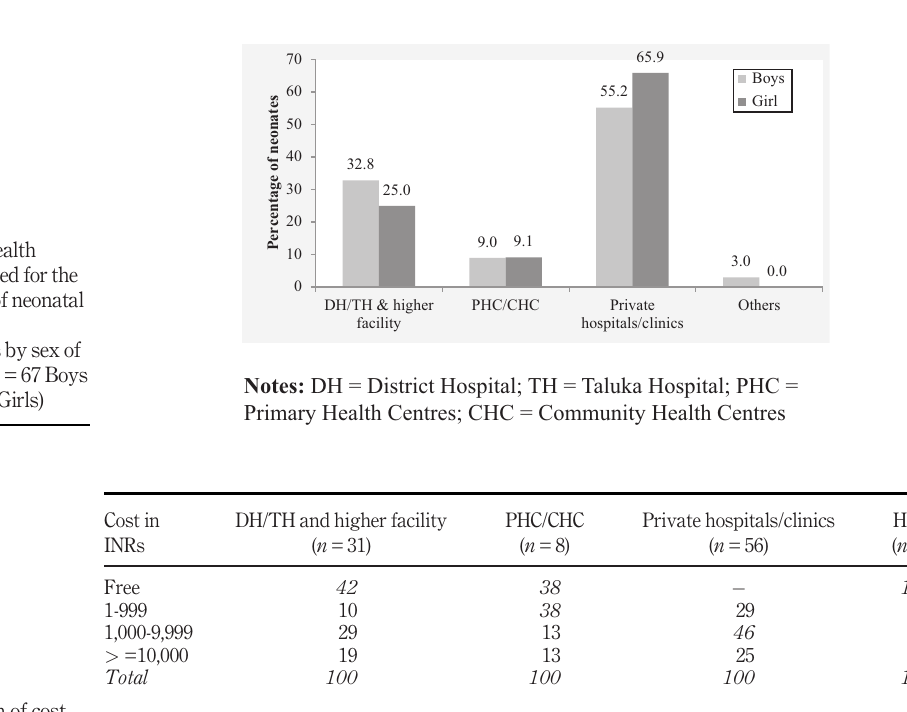
distribution of cost by place of treatment sought ( n =97)